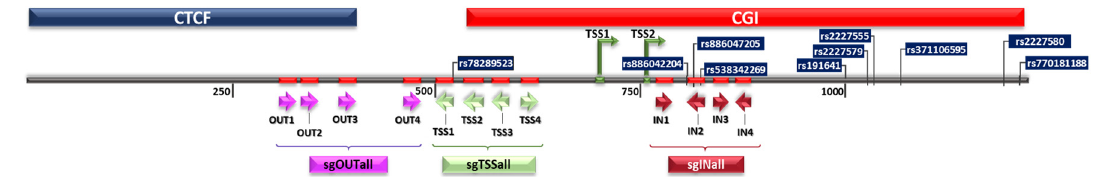
Figure 1. Position of sgRNAs designed to modulate PLAU gene expression.